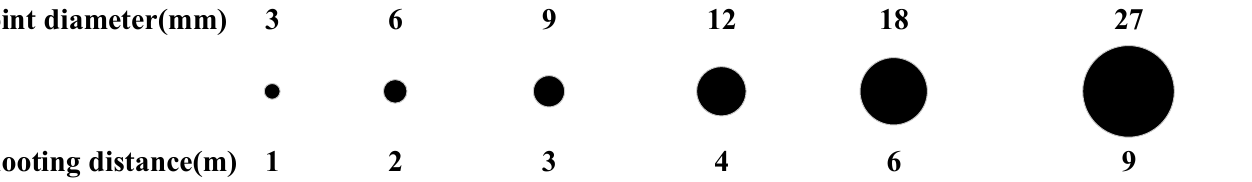
Figure 2. The relationship between point diameter and shooting distance.